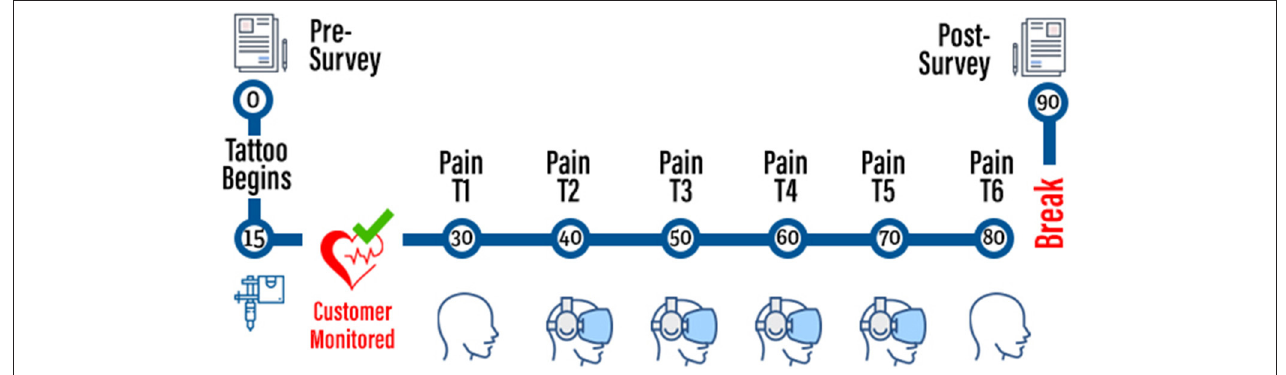
FIGURE 3 | Six randomly generated VHs pretested prior to the stimuli development.